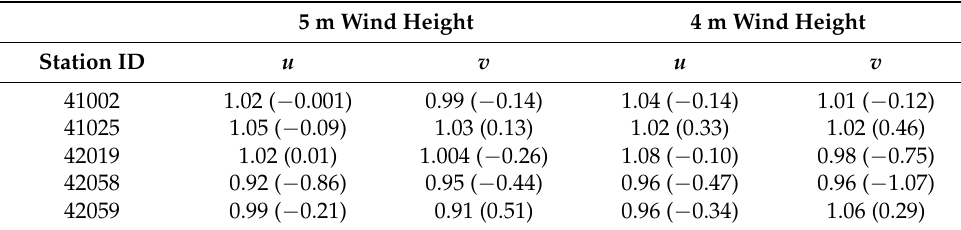
Table 4. Triple collocation calibration scaling factors and wind component bias (in parenthesis) of buoy (cid:1847) (cid:2869)(cid:2868)(cid:3020) in wind ‐ wave ‐ dominant seas for NDBC buoys before and after a switch in anemometer height from 5 to near 4 m.